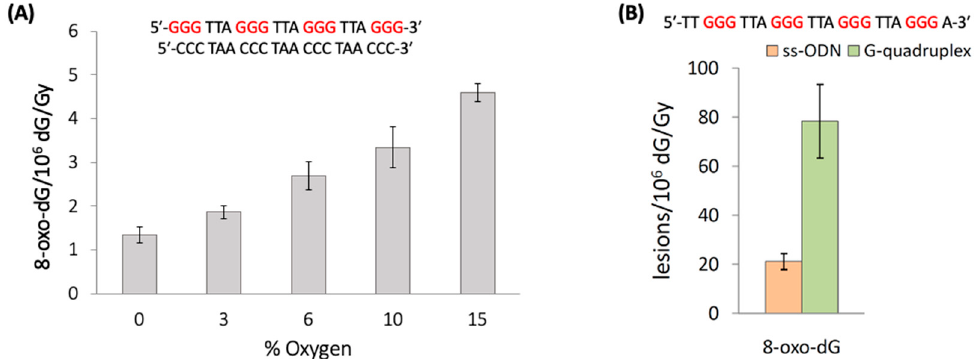
Figure 13. ( A ) Radiation-induced formation of 8-oxo-dG in ds-ODNs at increasing concentrations of oxygen; data from [84]. ( B ) Radiation-induced formation of 8-oxo-dG lesions in ss-ODN (nonfolded state) and G-quadruplex (folded state) in deareated conditions; the G-quadruplex was prepared by dissolving the oligonucleotides in 10 mM of KH 2 PO 4 buffer containing 70 mM of KClO 4 (pH 7.0). Values represent the mean ± SD per 10 6 dG per Gy of γ -irradiation in the range from 0 to 60 Gy of irradiation.